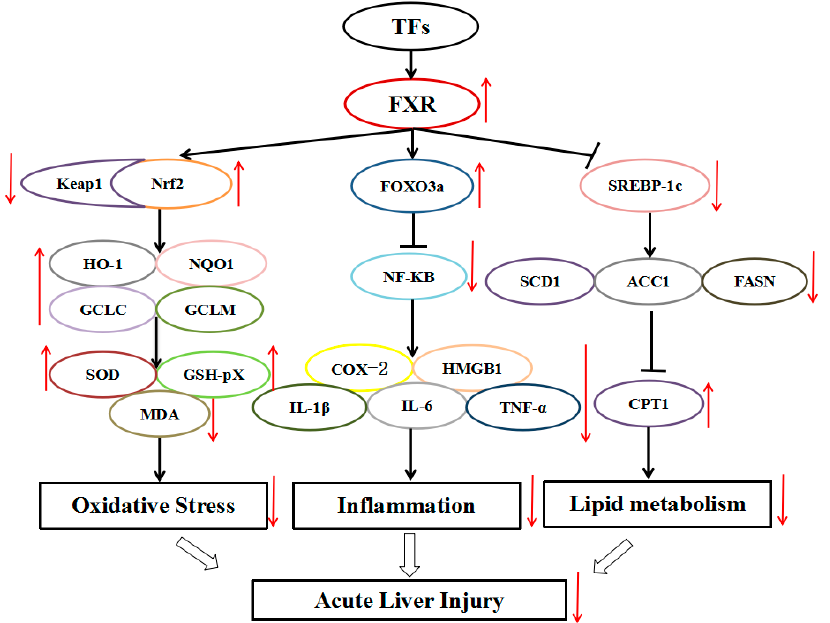
Figure 7. Schematic diagram showing the mechanism of action of TFs against LPS-induced acute liver injury. TFs reduced oxidative stress, inflammation, and lipid metabolism by modulating the FXR signal pathway.